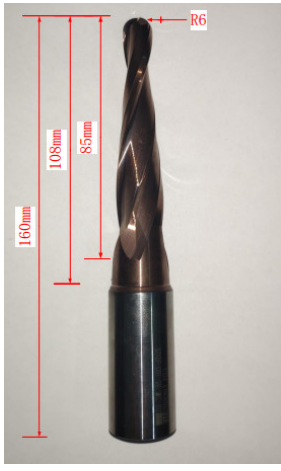
Figure 6. Taper milling cutter.